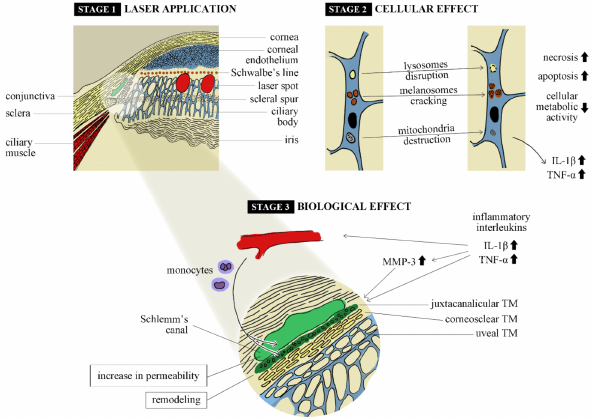
Figure 1. Summary of the trabecular meshwork tissue response induced by selective laser